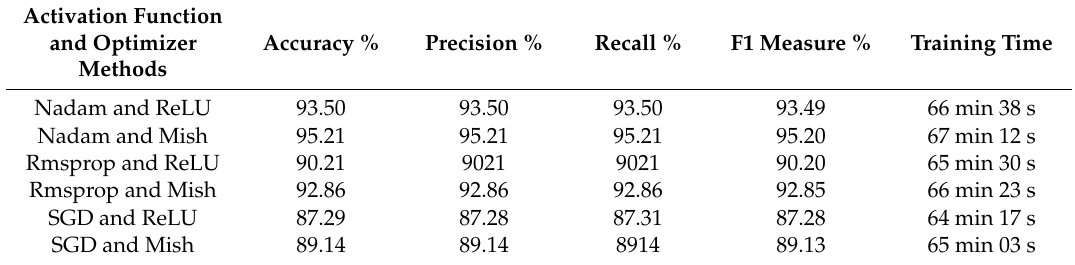
Table 4. The performance of Inception-V3 with ReLU and Mish combined with other optimizers.